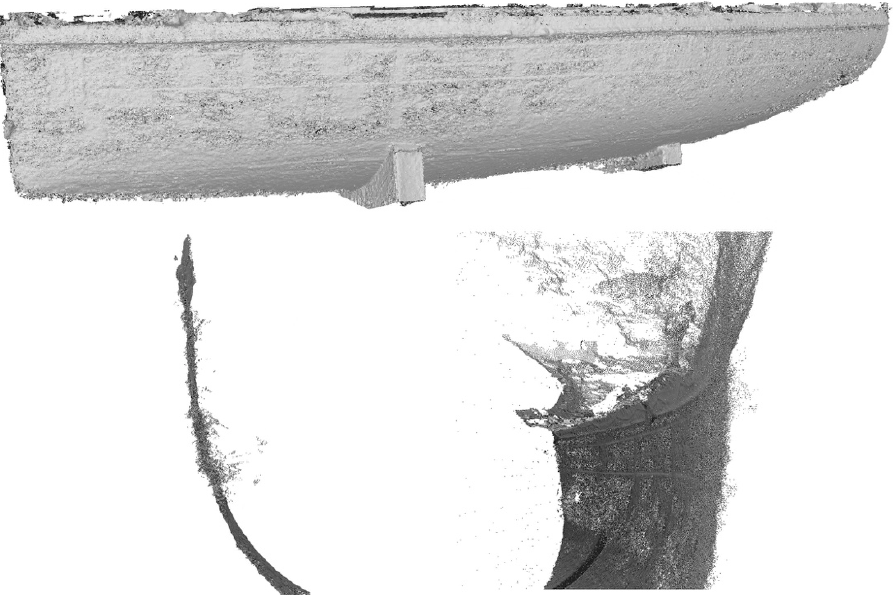
Figure 8. Up—an overall view of the final point cloud from Structure–from–Motion (SfM) processing; down—a cross-section through the final point cloud with visible noise.